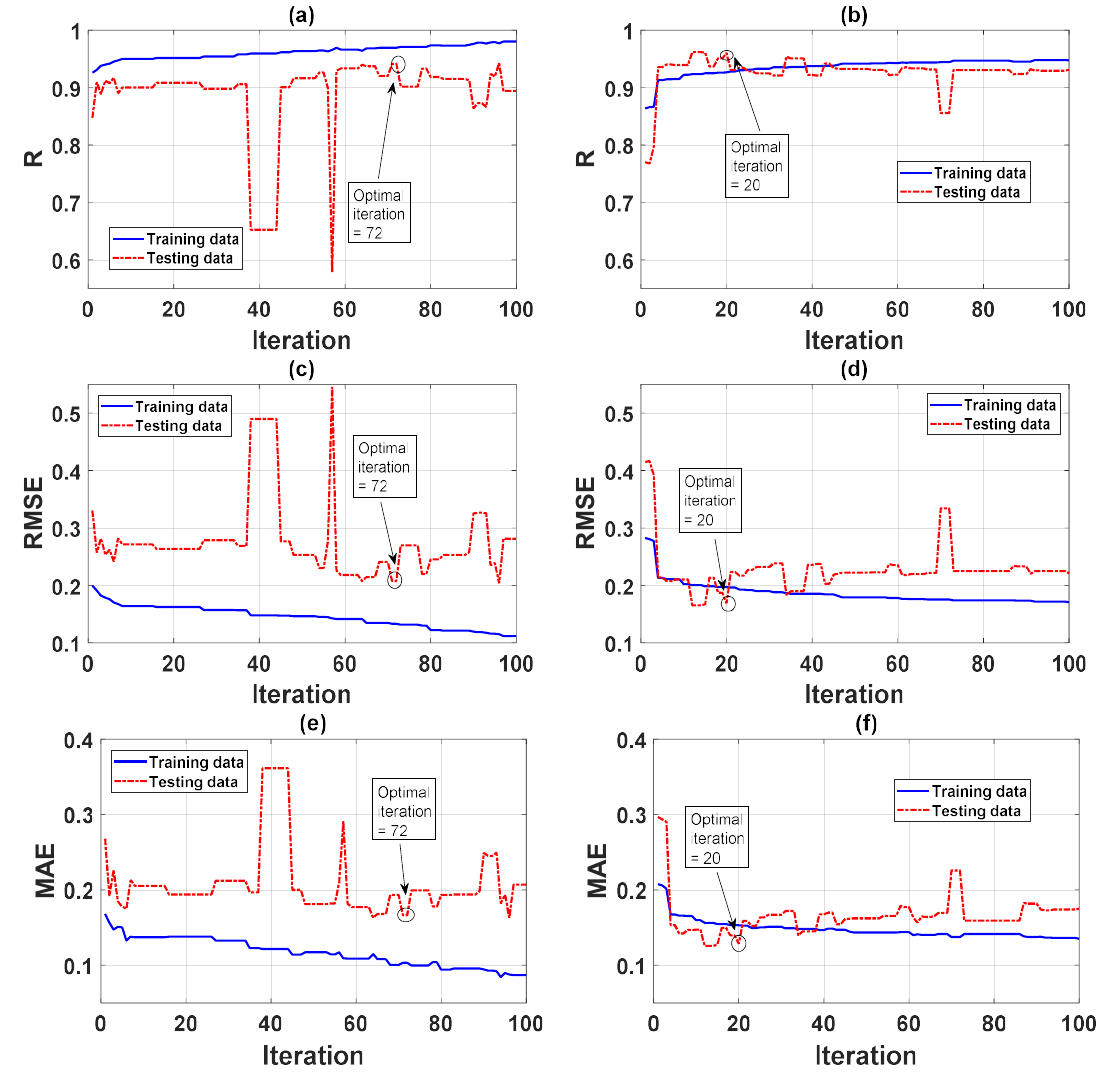
Figure 4. Optimization of ANFIS parameters using the SA technique for ( a ) R, ( c ) RMSE, and ( e ) MAE using the BBO technique for ( b ) R, ( d ) RMSE, and (f) MAE.